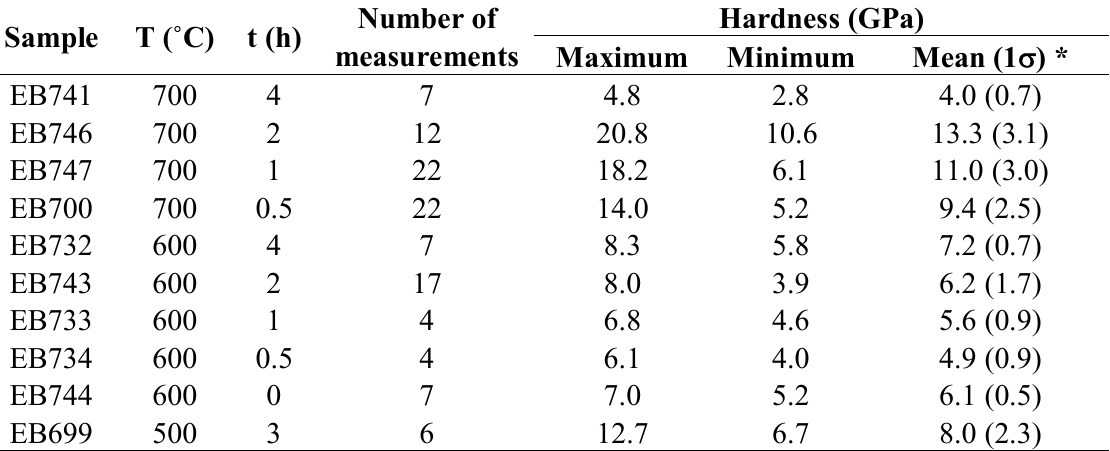
Table 2. Summary of Vickers hardness ( H experiments on Ti N samples annealed at 2 GPa. The applied loads ranged between 3 4 0.3–3 N.